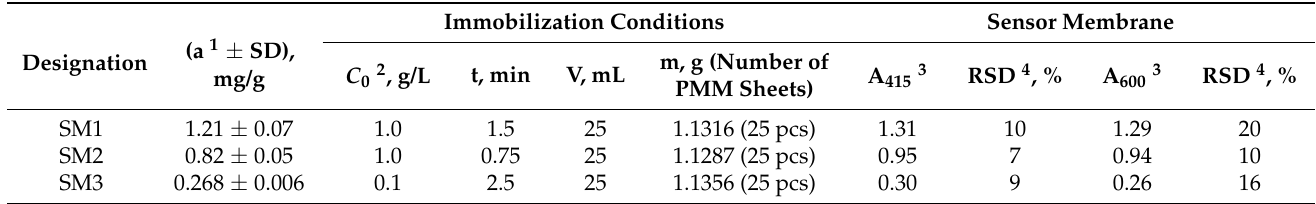
Table 1. Parameters of sensors membranes dependent on immobilization